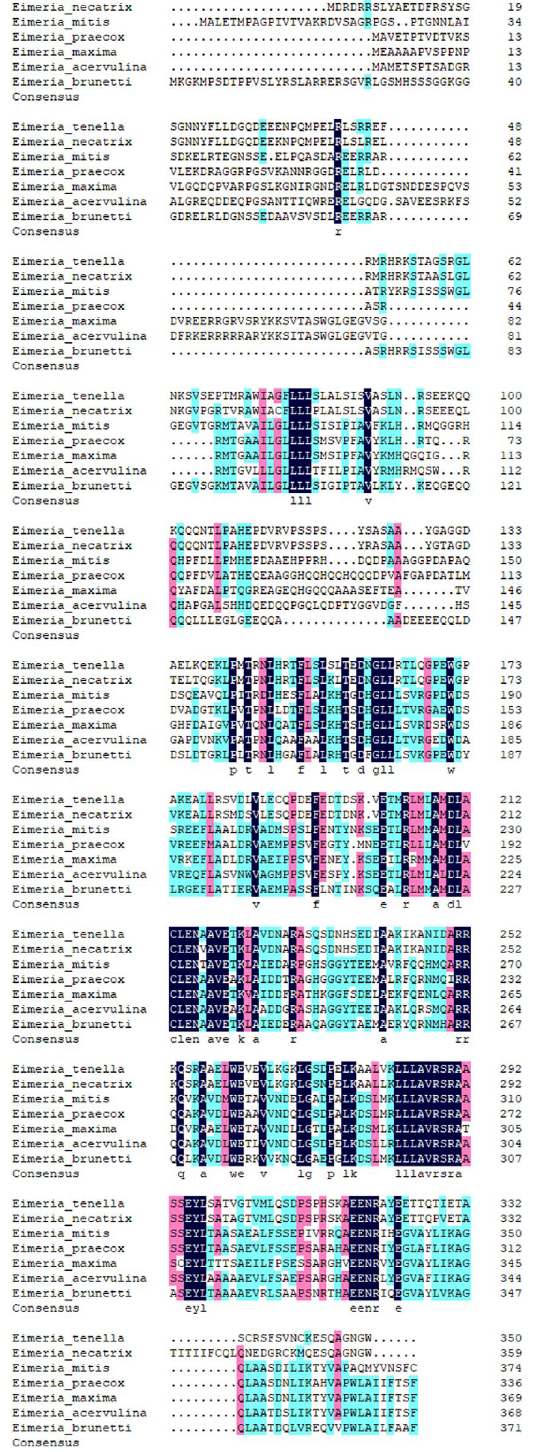
Figure 1. Multiple alignment analysis of Et CHP18905 with other Eimeria proteins. DNAMAN was used to analyze the deduced protein sequences. The identical amino acids are listed at the bottom.